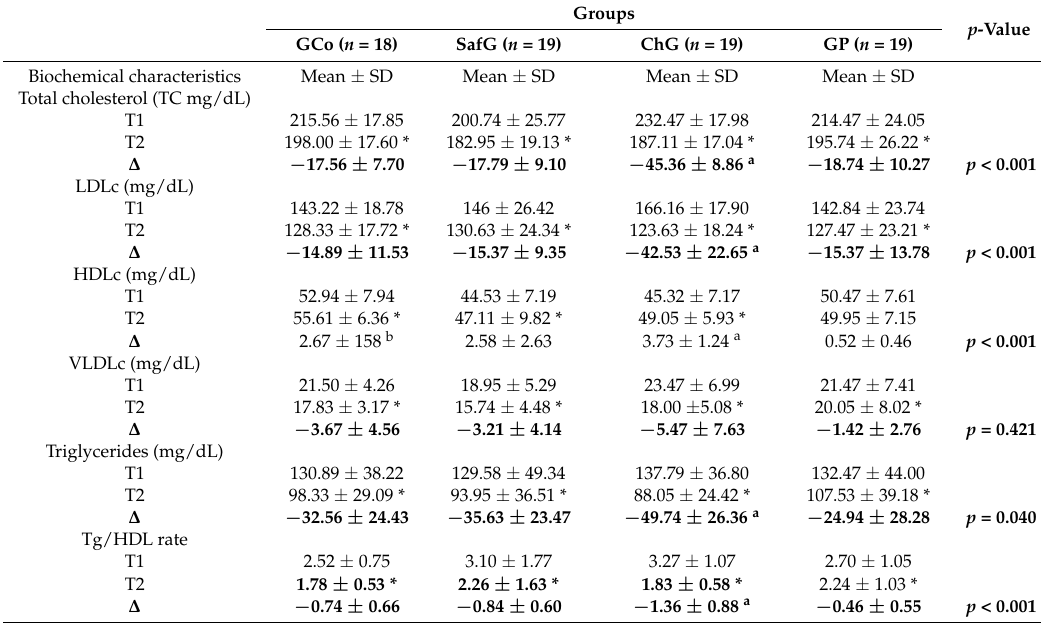
Table 3. Blood profile absolute variation of participants before (T1) and after (T2) the supplementation